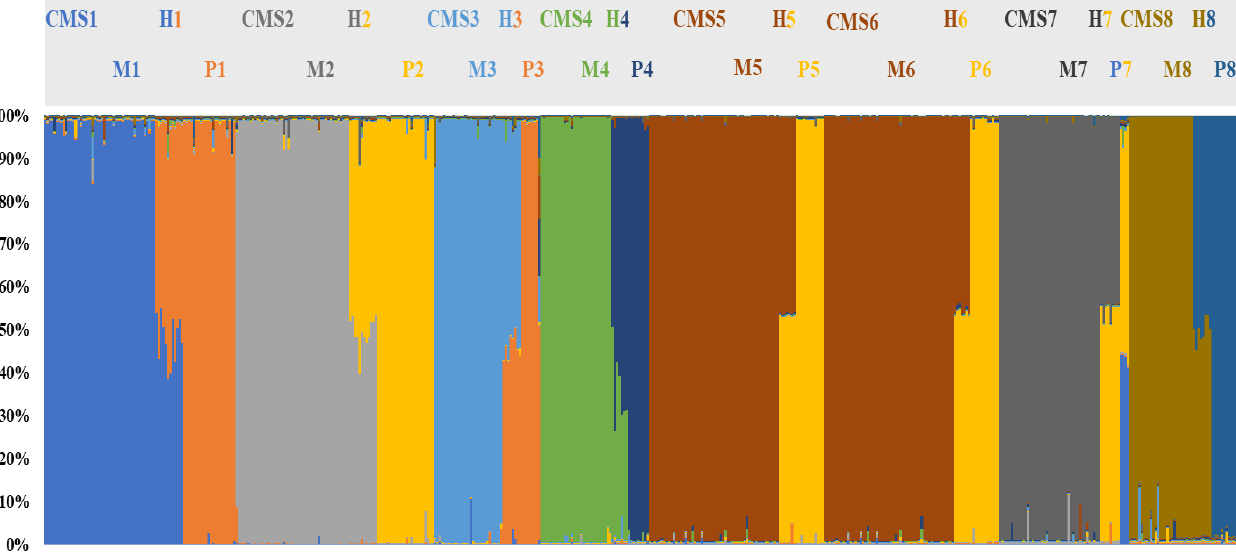
Figure 5. Histogram representing the membership of each sample to one of the 11 identified clusters. The names of each line are reported above bars and are labeled with the same color of the respective cluster.